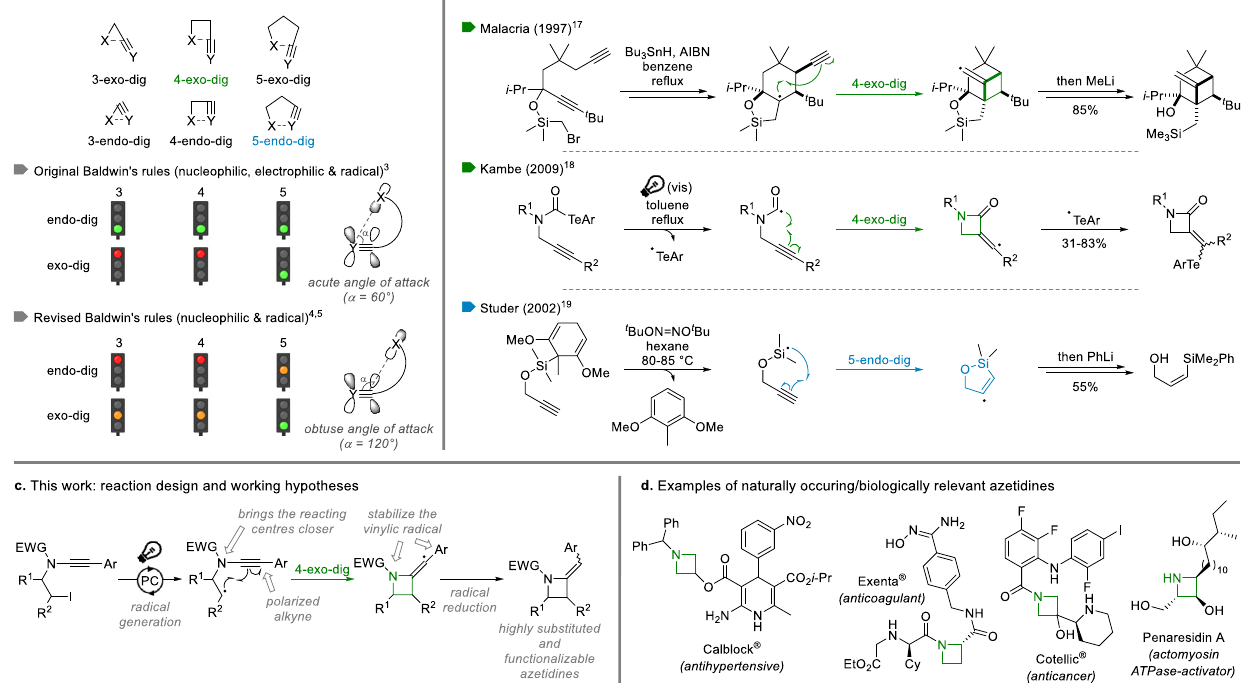
Fig. 1 Digonal ring closures for the synthesis of azetidines. a Original and revised Baldwin ’ s rules for digonal ring closures. b Rare examples of radical 4- exo-dig and 5-endo-dig cyclizations. c Reaction design: radical 4-exo-dig cyclization of ynamides triggered by visible-light activation with a photoredox catalyst (PC). d Representative examples of naturally occurring/biologically relevant